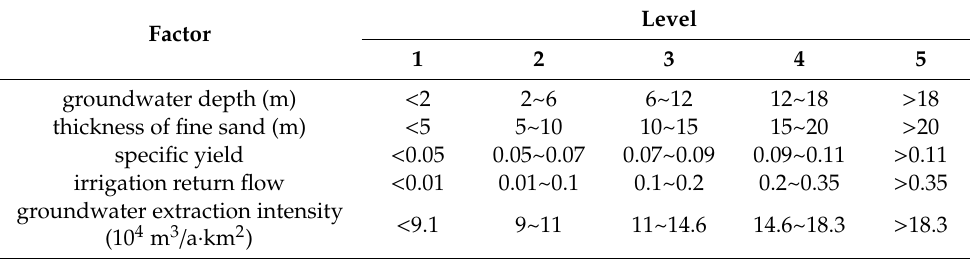
Table 1. Grading of evaluating